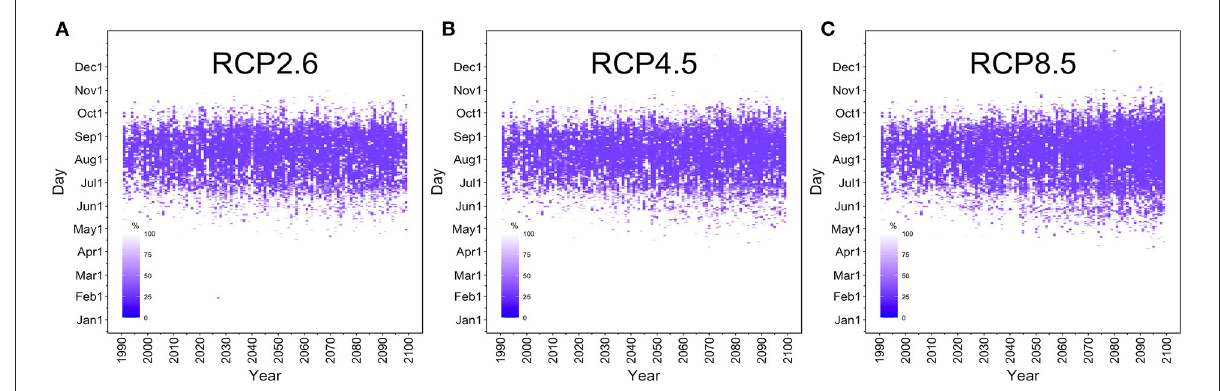
FIGURE3 Time-dependent changes in the dengue extinction probability in Tokyo. The horizontal axis shows the years 1990 to 2100. The vertical axis measures the period from January 1 to December 31. The density of the purple area reflects the daily extinction probability in Tokyo’s Yoyogi Park. The extinction probability at 100% is shown in white. (A) The RCP2.6 scenario, (B) RCP4.5 scenario, and (C) RCP8.5 scenario. Under the most optimistic RCP2.6 scenario, there is little difference between the years 2022 and 2100. However, under the RCP8.5 scenario, the risk of a large-scale dengue epidemic is gradually extended not only during the summer (June–September) but also in the autumn and spring to include November and April.